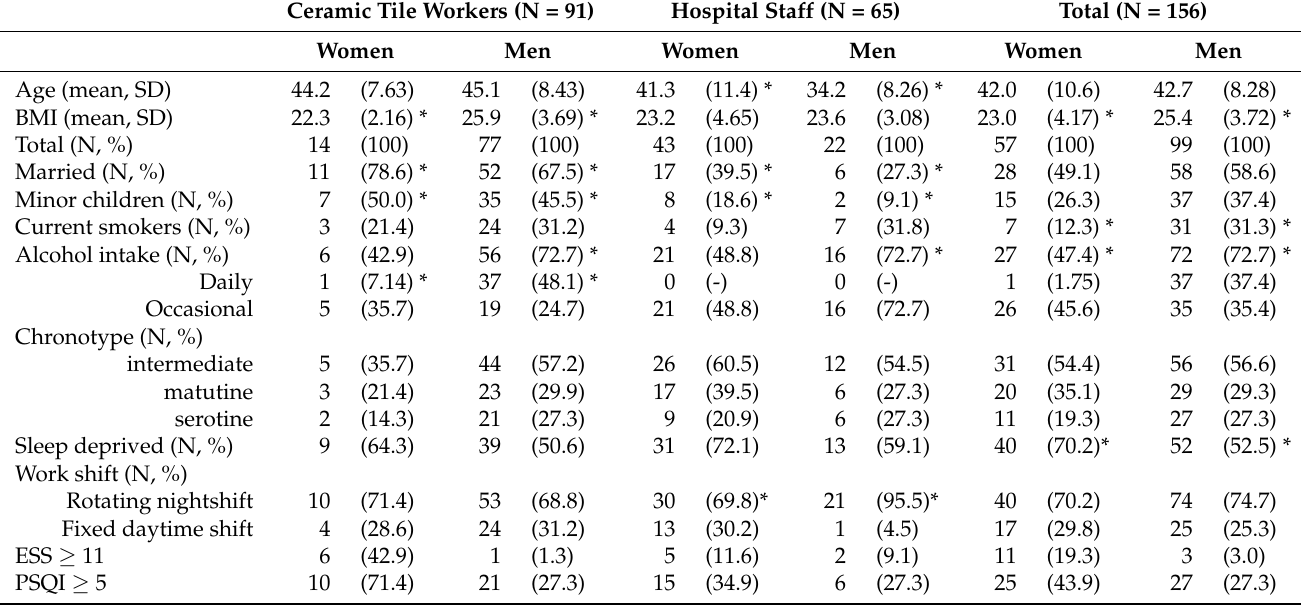
Table 1. Selected variables of the study population by workplace and